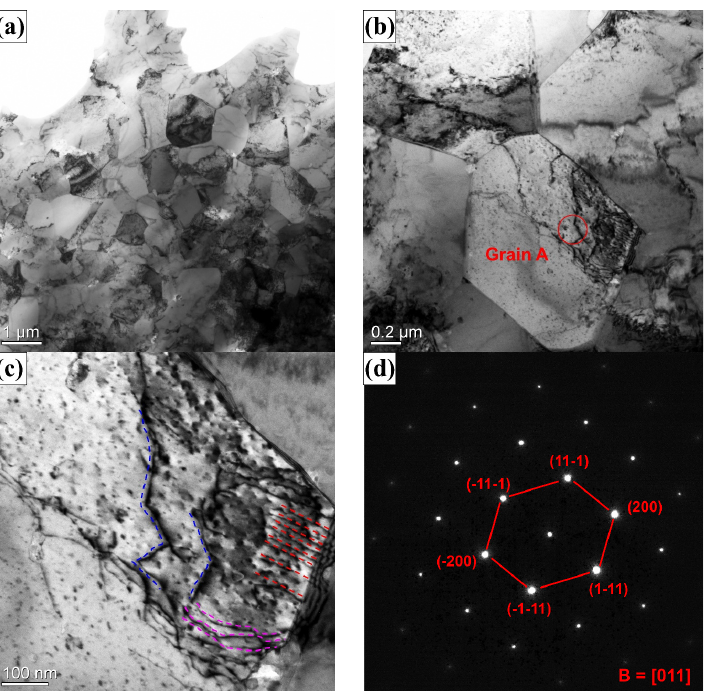
Figure 6. ( a , b ) BF image of typical microstructure of the alloy annealed at 800 ° C; ( c ) BF image exhibiting parallel GND on slip planes; ( d ) SAED pattern of grain A in ( b ).